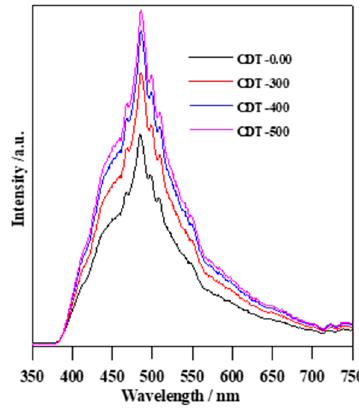
Figure 9. PL spectra of CDT-0.00, CDT-300, CDT-400, and CDT-500 catalysts.